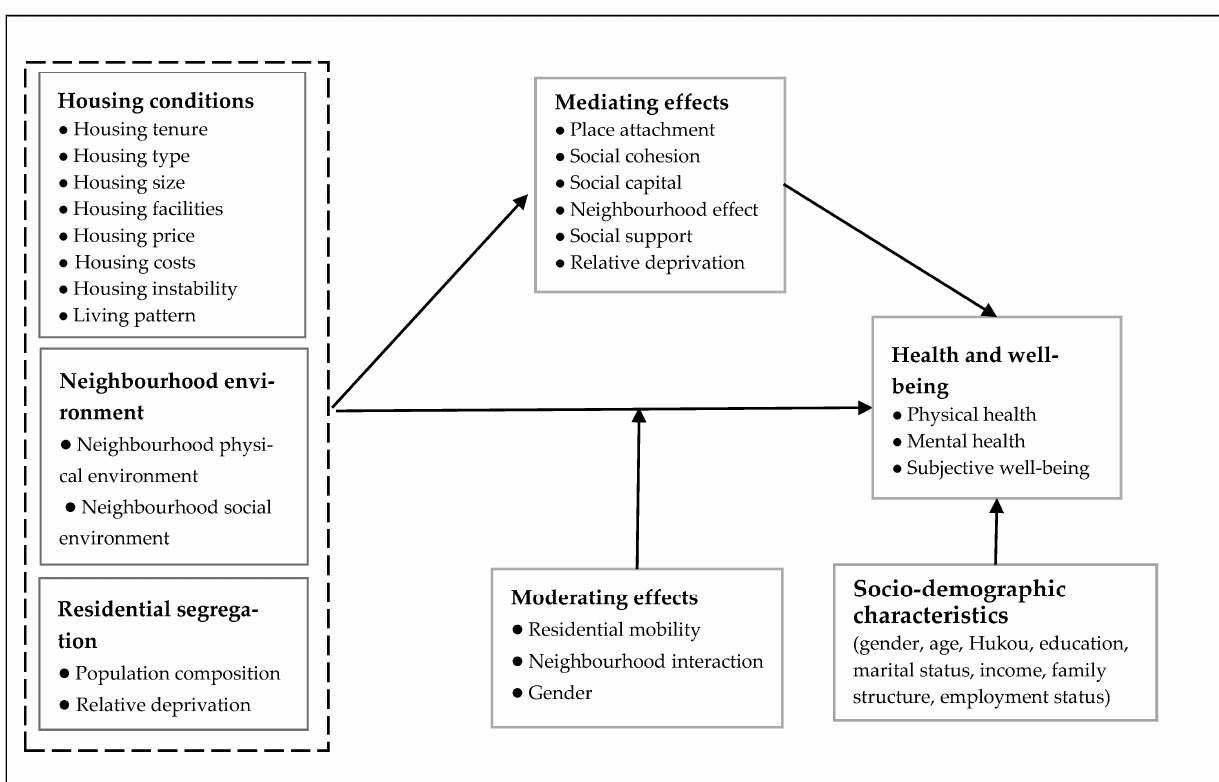
Figure 4. The conceptual framework of the impact of residential environment on migrants’ health and well-being.